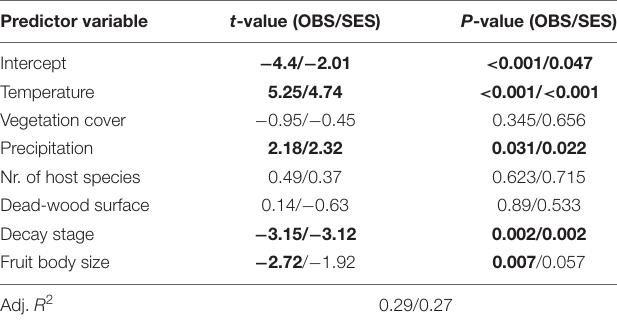
TABLE 1 | Multivariate linear model testing the effect of temperature on assemblage fruit body color